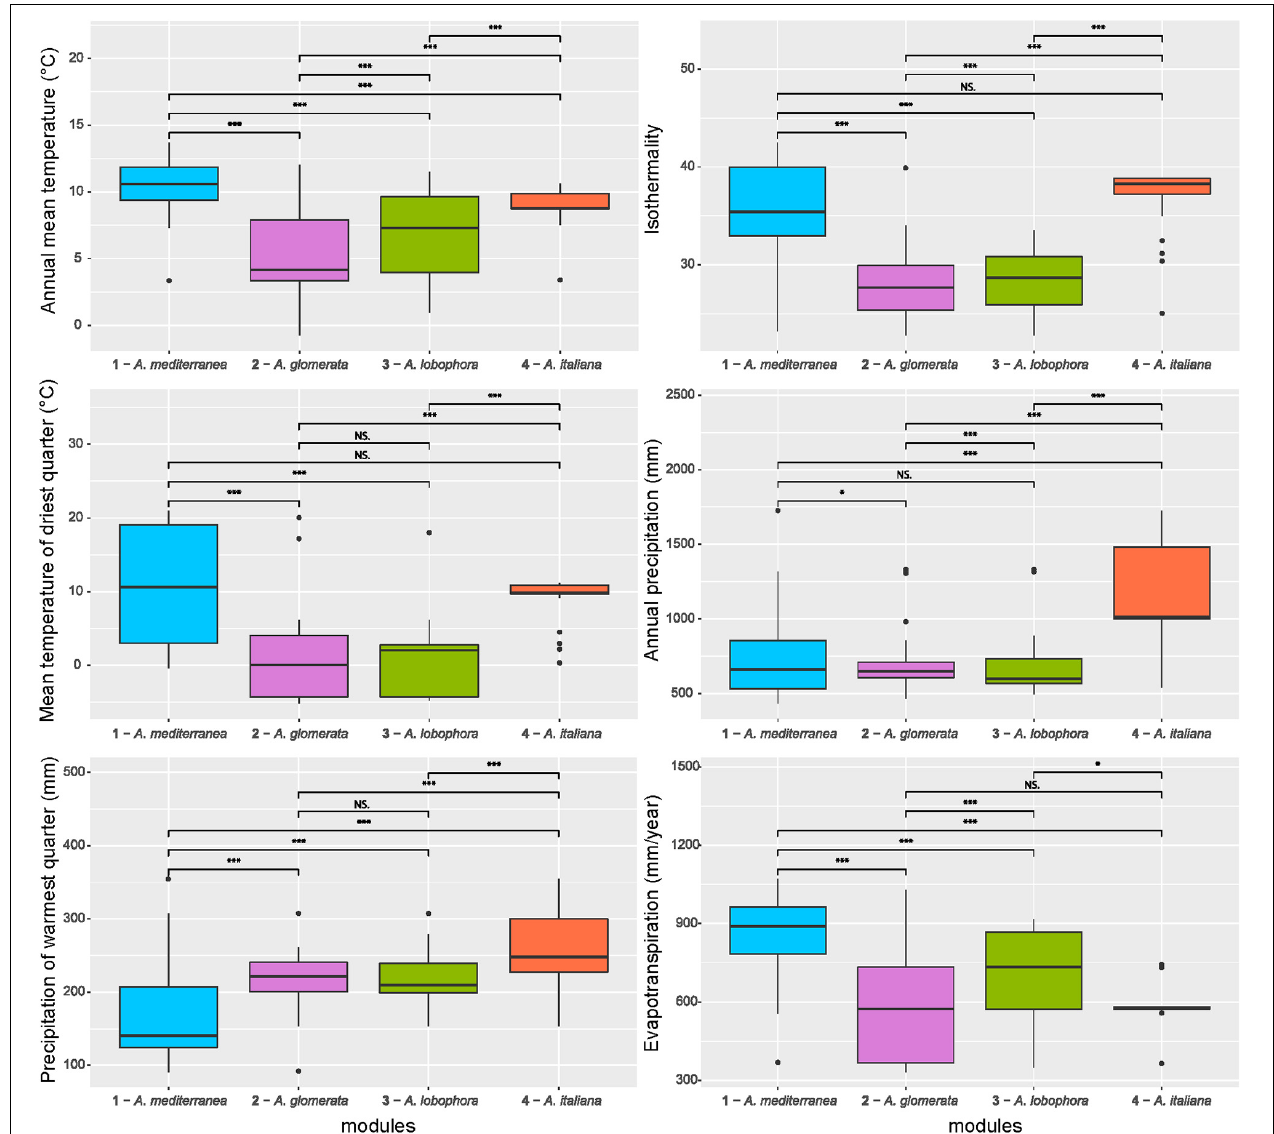
FIGURE 5 | Comparison of climatic variables between the photobiont-mycobiont modules. Significance levels, calculated by Wilcoxon test, are given: “ ∗∗∗ ” – p < 0.001, “ ∗ ” – p < 0.05, “NS” – not significant. Bold lines represent the median and whiskers account for the 95% confidence interval of the data. Outliers appear as